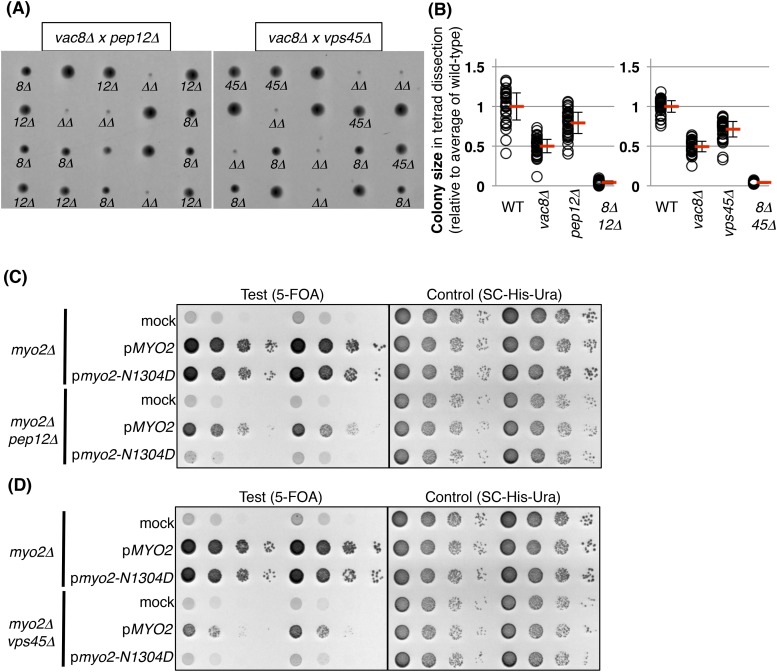
Pep12 and Vps45 are required for the viability of vacuole inheritance mutants.(A) A vac8Δ mutant exhibits a synthetic growth defect with either pep12Δ and vps45Δ. Results of tetrad dissections of heterozygous diploids, VAC8/vac8Δ PEP12/pep12Δ and VAC8/vac8Δ VPS45/vps45Δ. vac8Δ = 8Δ; pep12Δ = 12Δ; vps45Δ = 45Δ; vac8Δ pep12Δ or vac8Δ vps45Δ double mutant = ΔΔ are indicated. (B) Quantification of colony size, relative to average of wild-type colonies. A total 35 tetrads and 37 tetrads were analyzed for vac8Δ pep12Δ and vac8Δ vps45Δ, respectively. (C) The pep12Δ mutant exhibits a synthetic growth defect with myo2-N1304D, which is a vacuole inheritance mutant due to a defect in binding to Vac17. Survival occurs when wild-type MYO2 is expressed in myo2Δ cells, and in the myo2Δ pep12Δ mutant. In addition, the myo2-N1304D mutant expressed in myo2Δ cells is sufficient for survival. In contrast, the myo2-N1304D mutant expressed in myo2Δ pep12Δ cells is lethal. Plasmids were transformed into a myo2Δ strain and a myo2Δ pep12Δ strain containing YCp50 [URA3] MYO2. Plasmids tested were pRS413 [HIS3] (mock), pRS413 MYO2 (pMYO2), or pRS413 myo2-N1304D (pmyo2-N1304D). Transformed colonies were cultured in SC-His-Ura liquid media and serial dilutions spotted onto SC+5-FOA plates to counter select against YCp50 [URA3] MYO2 (middle panel) and the same culture was also tested on SC-His-Ura plate (right panel). (D) A vps45Δ mutant exhibits a synthetic growth defect with the myo2-N1304D mutant. Wild-type MYO2 expressed in myo2Δ cells, or in the myo2Δ vps45Δ mutant, is sufficient for cell viability. In addition, the myo2-N1304D mutant expressed in myo2Δ cells is sufficient for cell viability. In contrast, the myo2-N1304D mutant expressed in myo2Δ vps45Δ cells is lethal.